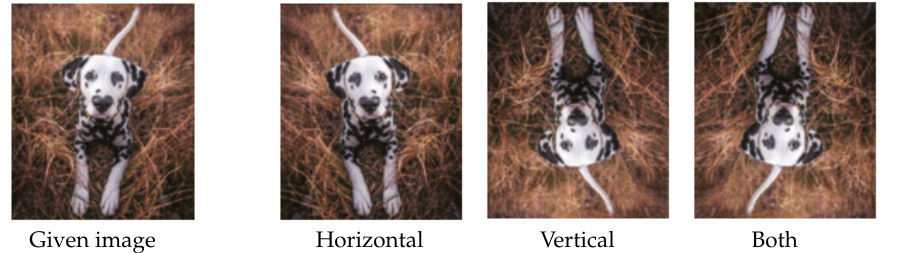
Figure 6. Data augmentation by flipping. Images from left to right represent the given image, horizontally flipped image, vertically flipped image and the image flipped horizontally and vertically, respectively.